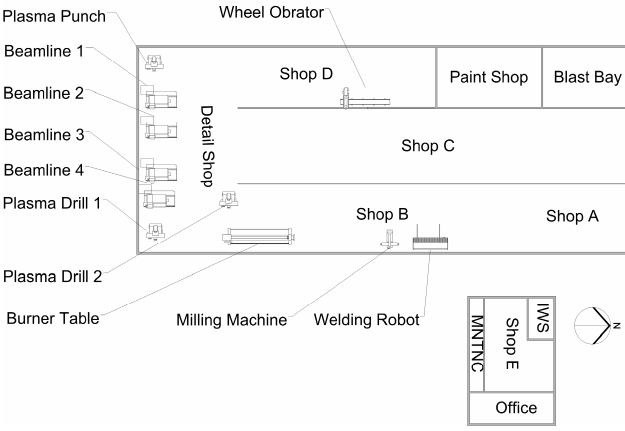
Figure 1. Floorplan of workshops detailing plant operation.